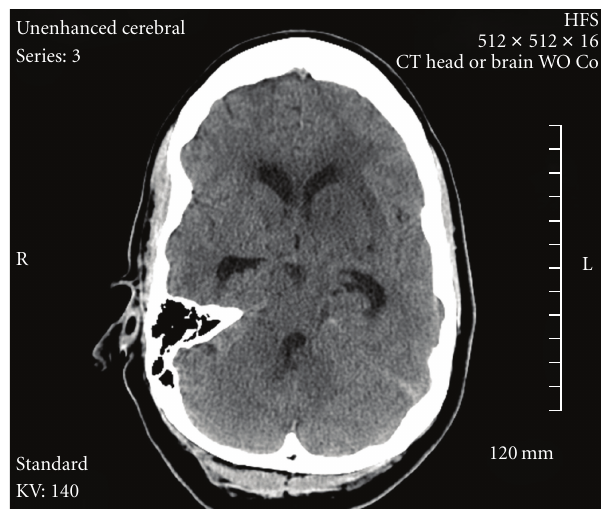
Figure 3: Noncontrast CT scan after 24hours of intrasinus rt-PA.